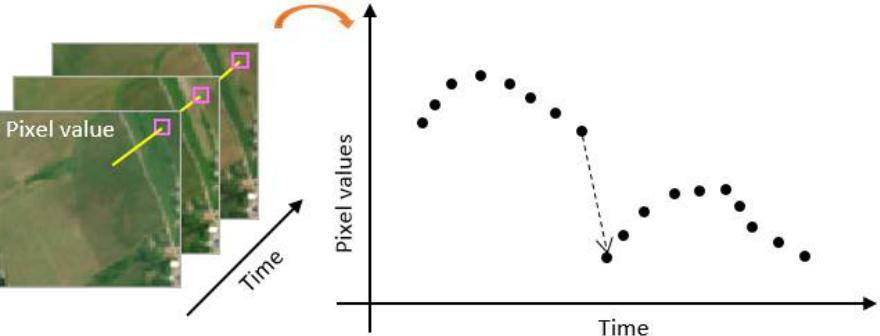
Figure 2. ( Left ) Series of Sentinel 2 satellite photos of the same geographical area with one chosen pixel in the top right corner. ( Right ) Symbolic depiction of the time series of the reflectance values in one spectral band for the chosen pixel, with an abrupt change in the middle (indicated by the dashed arrow), which might signify an invasive human activity, such as plowing or harvesting.